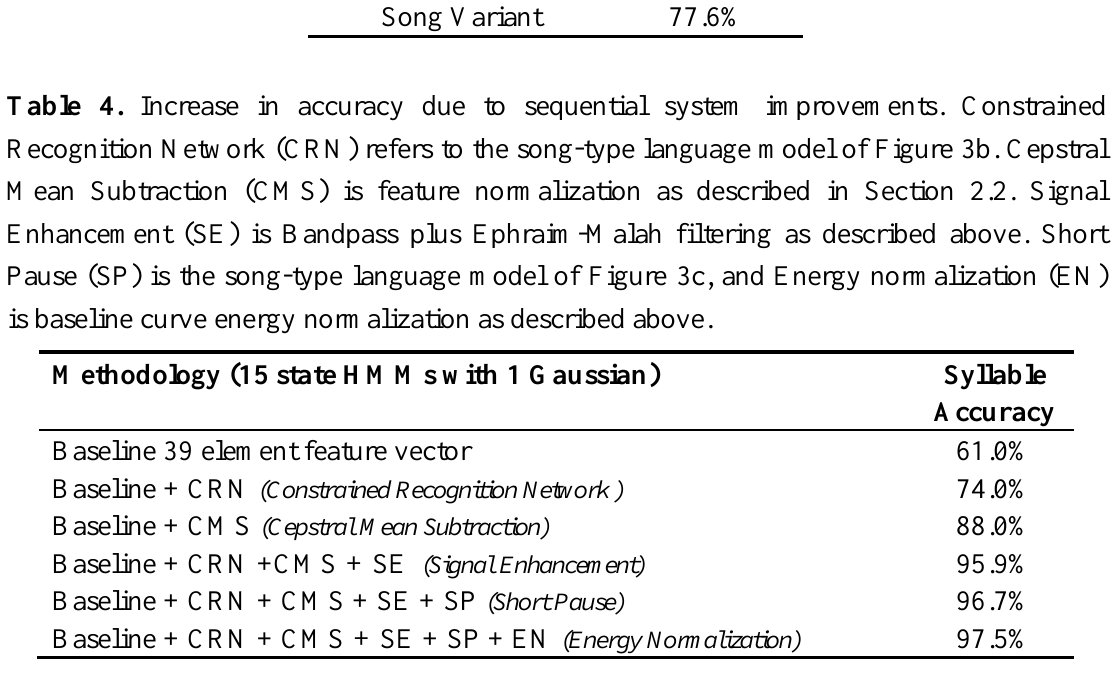
Table 4. Increase in accuracy due to sequential system improvements.